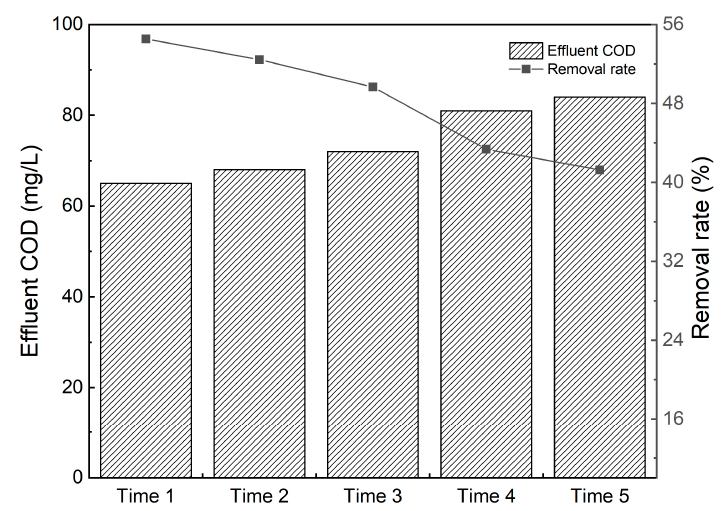
Figure 8. Adsorption–desorption performance of